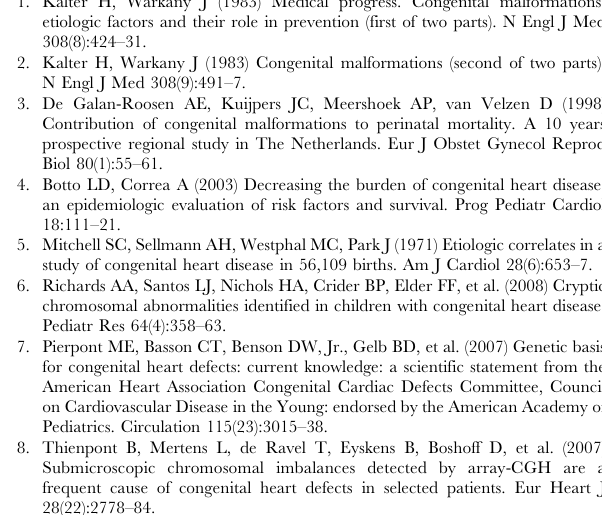
Table S5 MLPA probes used to discard well-known genetic alterations related to MCA/MR. Hg19 assembly. Table S6 MLPA probes used to validate the alterations detected by CMA and to study parental samples. Hg19 assembly. Table S7 Summary of rare copy number variations . 100 kb detected in samples of 168 control subjects. Hg19